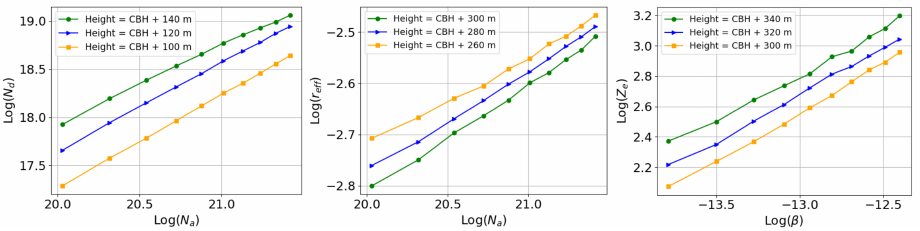
Figure 4. Dependence between log ( N a ) and log ( N D ) ( left ), between log ( N a ) and log ( r ef f ) ( center ), and between log ( Z e ) and log ( β ) ( right ) at three different heights varying the initial number of aerosol for the accumulation mode ammonium sulfate using ten iterations. Input parameters of Table